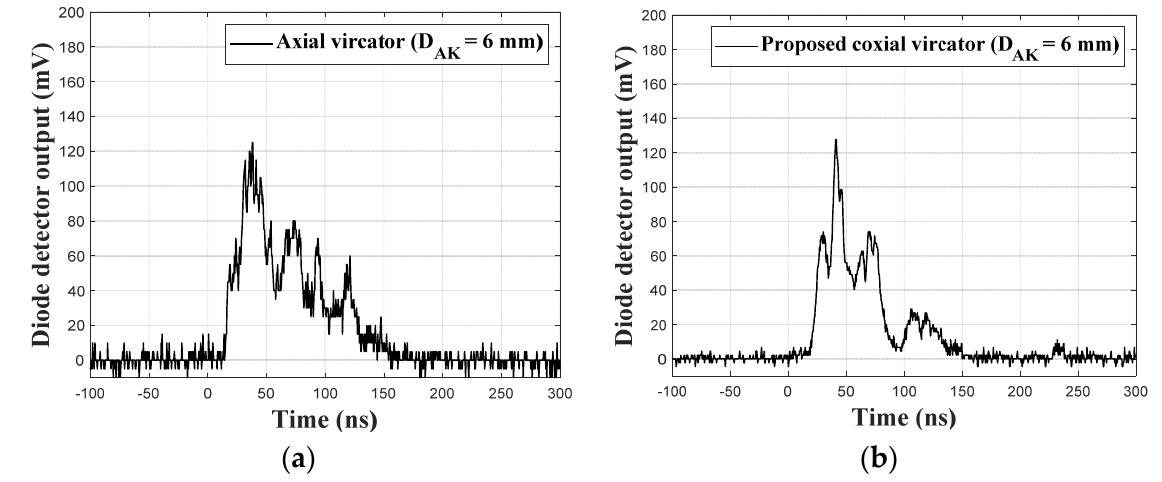
Figure 9. Typical diode detector output waveform of the vircator (D AK = 6 mm): ( a ) axial vircator and ( b ) coaxial vircator. Table 4. Experimental results on the vircator.